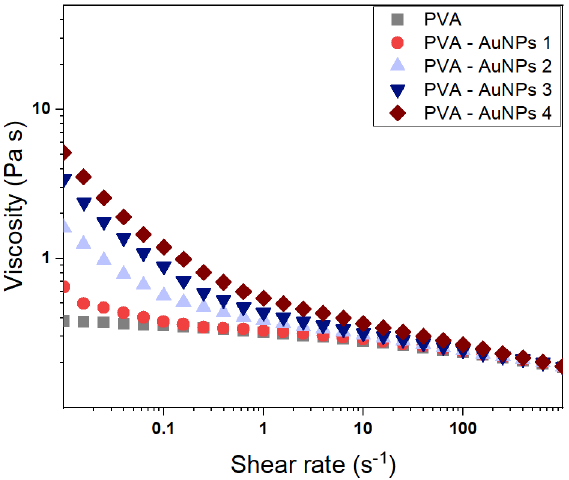
Figure 3. Steady-state viscosity curves of PVA-AuNPs suspensions measured at T = 25 °C. The PVA solution (i.e., gray symbols) is characterized by the typical shear-thinning behavior of polymeric fluids with a constant viscosity at a low shear rate (i.e., Newtonian region) followed by a decrease of the viscosity as the shear rate is increased. Such a char- acteristic is commonly associated with the chain disentanglement induced by the applied shear and the related orientation of the macromolecules, which in turn reduces the poly- mer network density [41–43]. Generally speaking, beyond the viscosity value at rest (i.e.,